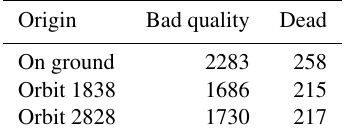
Table 3. Number of detector pixels labelled as “bad” (quality < 0 . 8) or “dead” (quality < 0.1). Note that this does not cover the total 250000 detector pixels. The area used for retrieval, and adopted above, equals approximately 210000